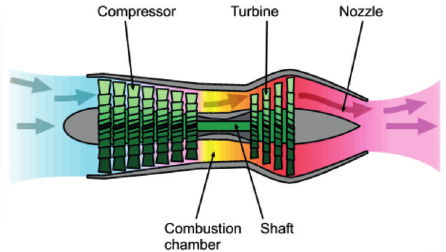
Fig. 7. Axial-flow compressor engine